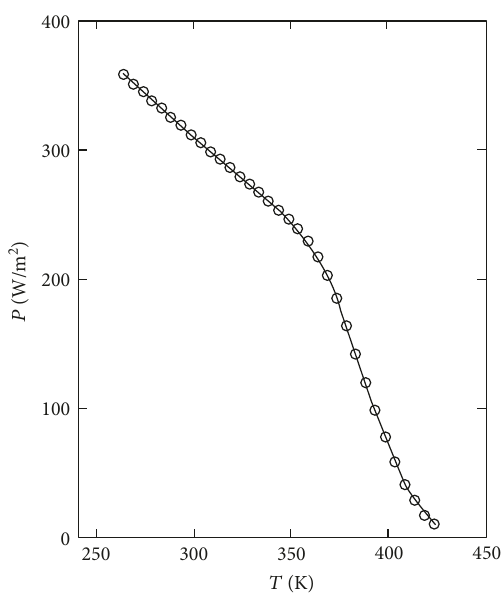
Figure 4: The maximum output power density of the tandem cell versus temperature, for the thicknesses 0.64 μ m and 60.62 μ m of Cu O layer and c-Si layer, 2